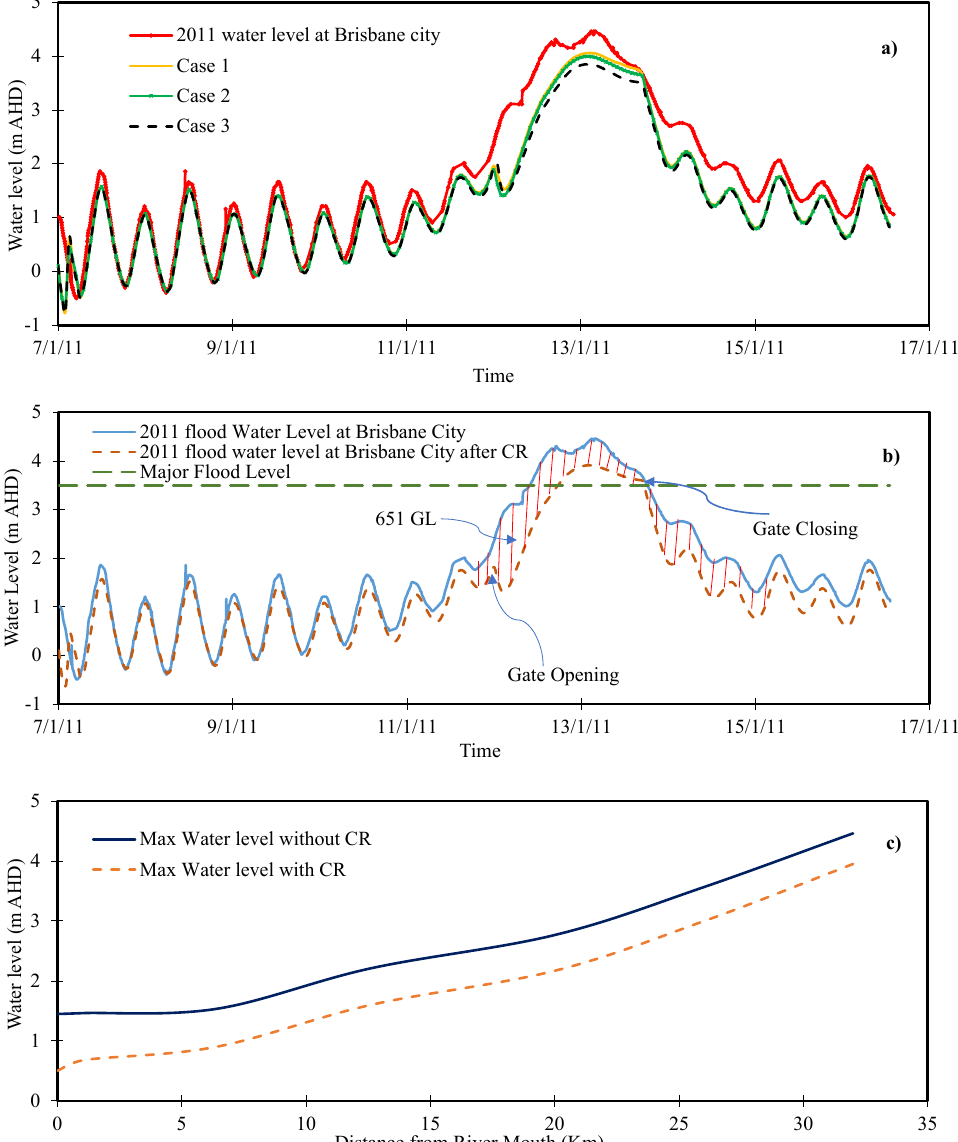
Figure 11. ( a ) Comparison of water level for 2011 flood event at Brisbane City with 3 cases of gate operation; ( b ) Comparison of water level for 2011 flood event at Brisbane City with and without CR for optimum water level reduction; ( c ) Comparison of longitudinal water level profile in BRE with and without CR.